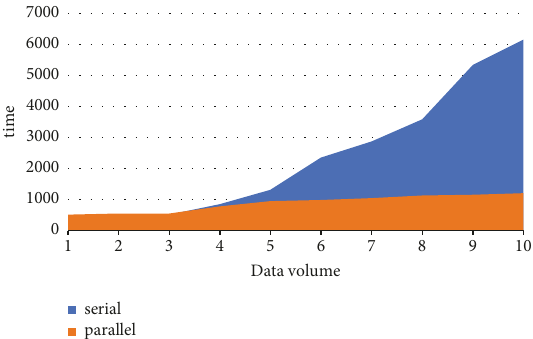
Figure 4: Comparison of parallel and serial time.